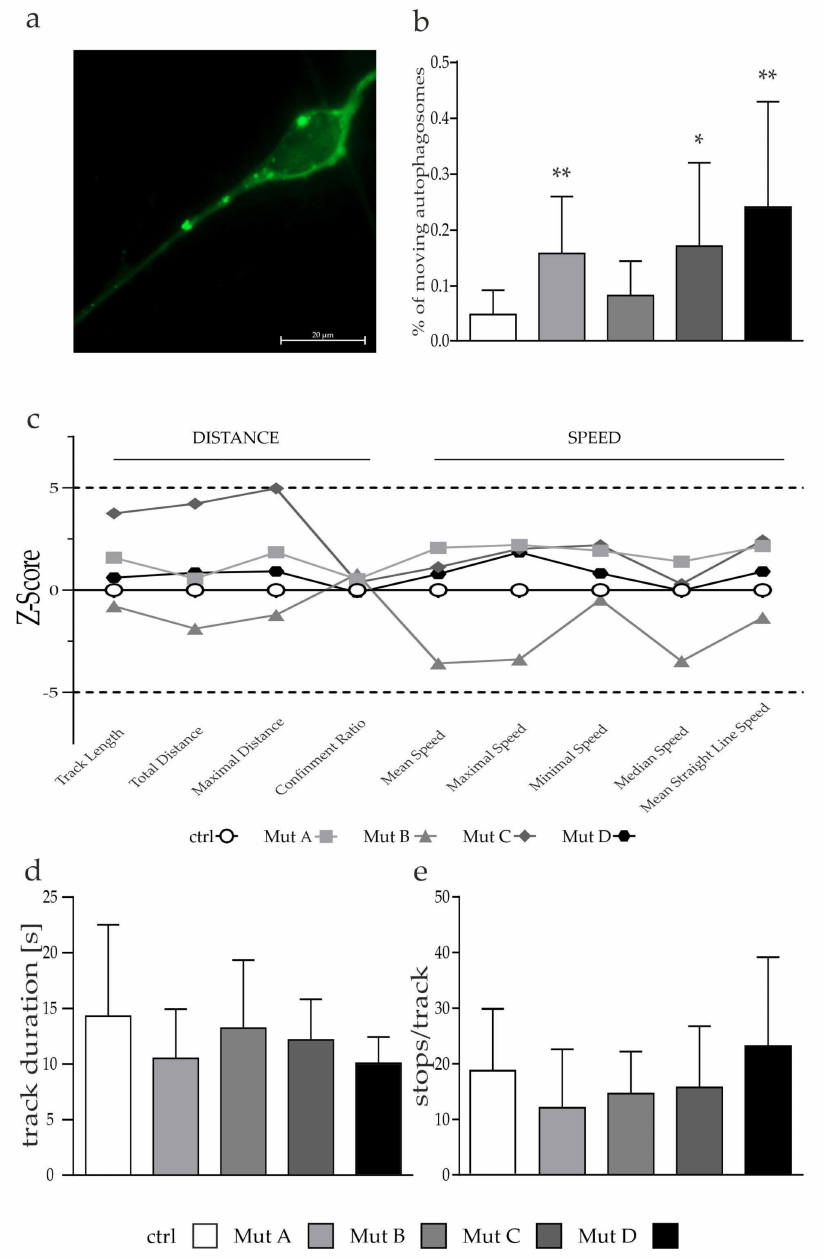
Figure 7. Analysis of autophagosomal transport. ( a ) Example picture of cells transduced with the Premo TM Autophagy Sensor LC3B-GFP. Scalebar = 20 µ m ( b ) NPC-deficient cells displayed a significantly increased percentage of moving autophagosomes, with the exception of Mut B. ( c ) Z- score for speed and distance parameters. Dashed lines indicate a Z-score higher than 5 and lower than –5, set as significance levels. The symbols of the individual parameters are connected with a line. This was not intended to indicate any relationship between the individual parameters, but only serves to improve the interpretability of the data presented. ( d ) Bar graph of the track duration and ( e ) stops per track were not different from the control cell line. Graphs in ( b , d , e ) show mean ± SD with N = 4–5, n = 17–23. One-way ANOVA and Dunnet’s multiple comparison post hoc test were used to determine statistical significance, with * = p < 0.05, ** = p < 0.01. Mut A (NP-C1): c.1180T>C; Mut B (NP-C1): c.1836A>C/c.1628delC; Mut C (NP-C1): c.3182T>C; Mut D (NP-C2):